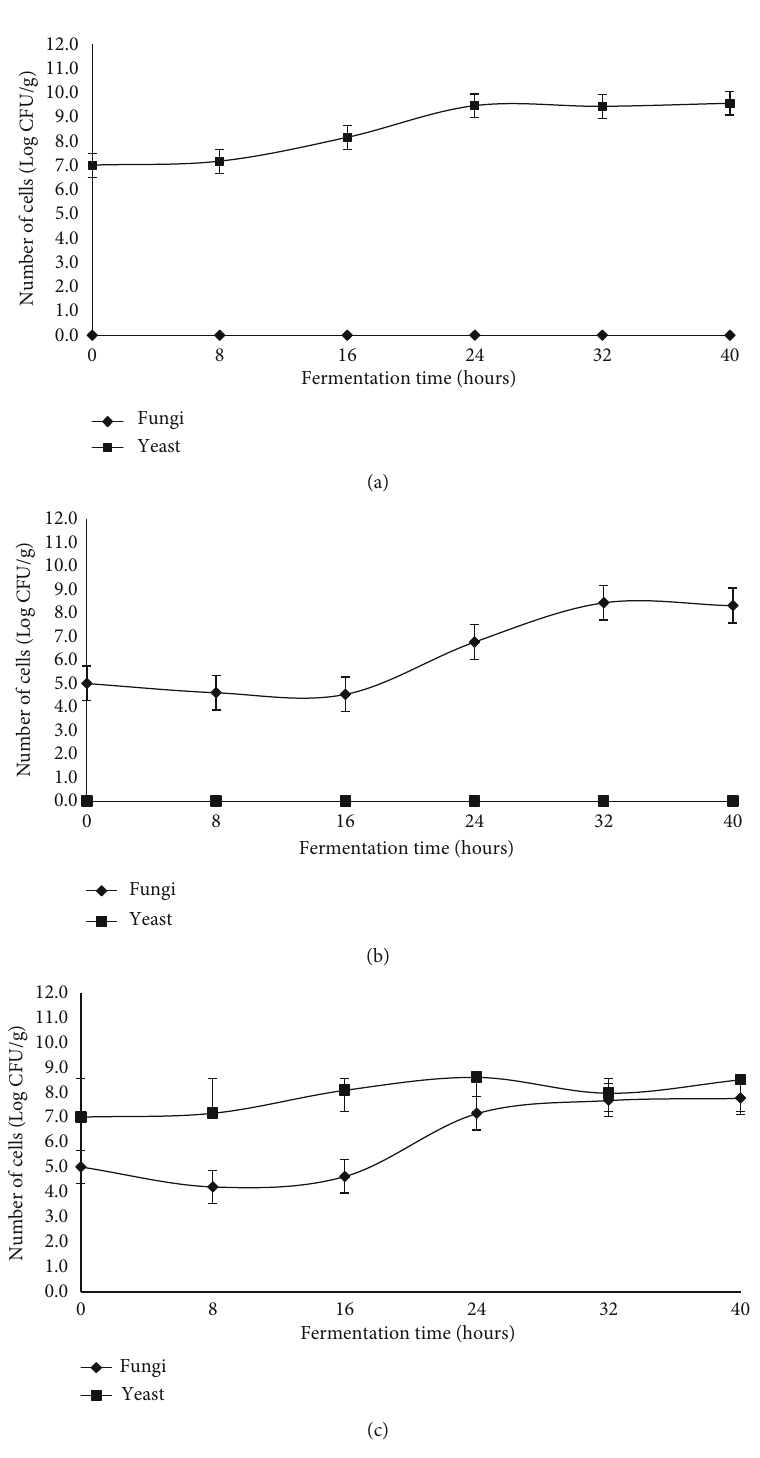
Figure 1: The growth curves of yeast and fungi during soybean fermentation inoculated with a single culture of S . cerevisiae (a), a single culture of R . oligosporus (b), and a mixed culture of both microorganisms